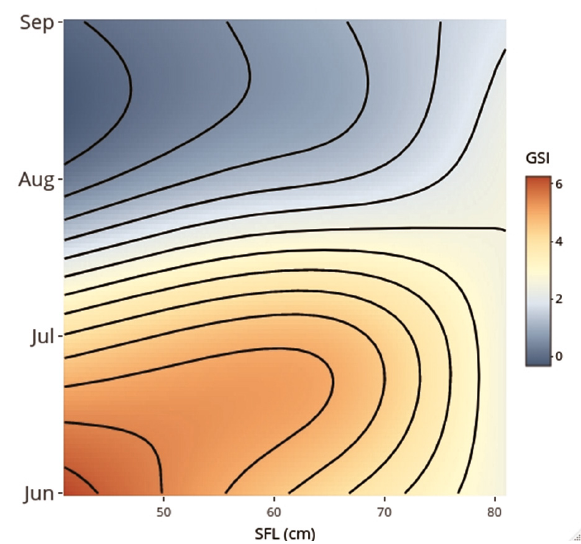
Fig. 2. – Monthly average of GSI as a function of round weight Fig. 3. – Contour plot of the fitted GAM for the GSI as a function (RW): females (blue line) and males (red line). of months and size. Straight fork length on the x-axis, month on the y-axis and the response values (GSI) given by the isolines (gray colour indicates the lowest and orange the highest GSI values).